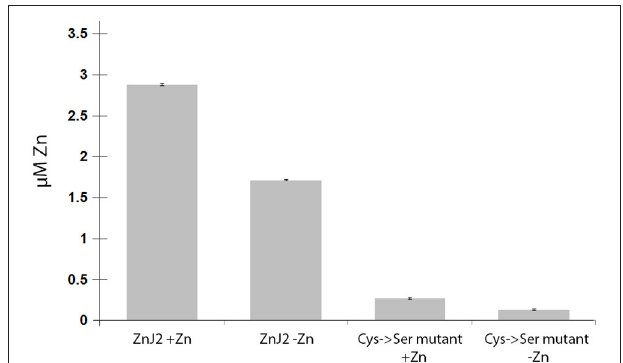
FIGURE 1 | ZnJ2 is a Zinc-binding protein. Purified recombinant ZnJ2 (3 µ M) or its Cys- > Ser mutant were pre-incubated with 100 µ M ZnCl2 to obtain full saturation of the tested proteins with bound zinc ( + Zn). Control samples of both proteins were not treated with zinc before the assay (–Zn). The proteins were then dialyzed against free-metal buffer and further incubated in 1mL buffer containing 0.1mM PAR in 40mM KH 2 PO 4 . The zinc release was obtained using PCMB and the PAR(Zn) 2 complex was monitored at 500nm. Each assay was performed in